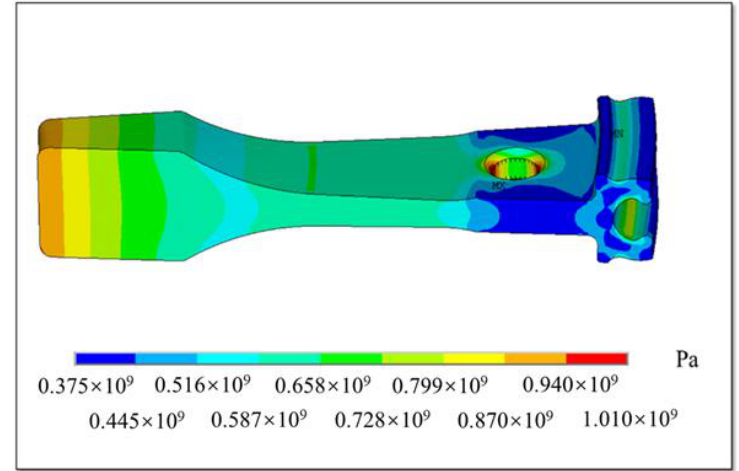
Figure 4. Equivalent stress distribution of the compressor disk.